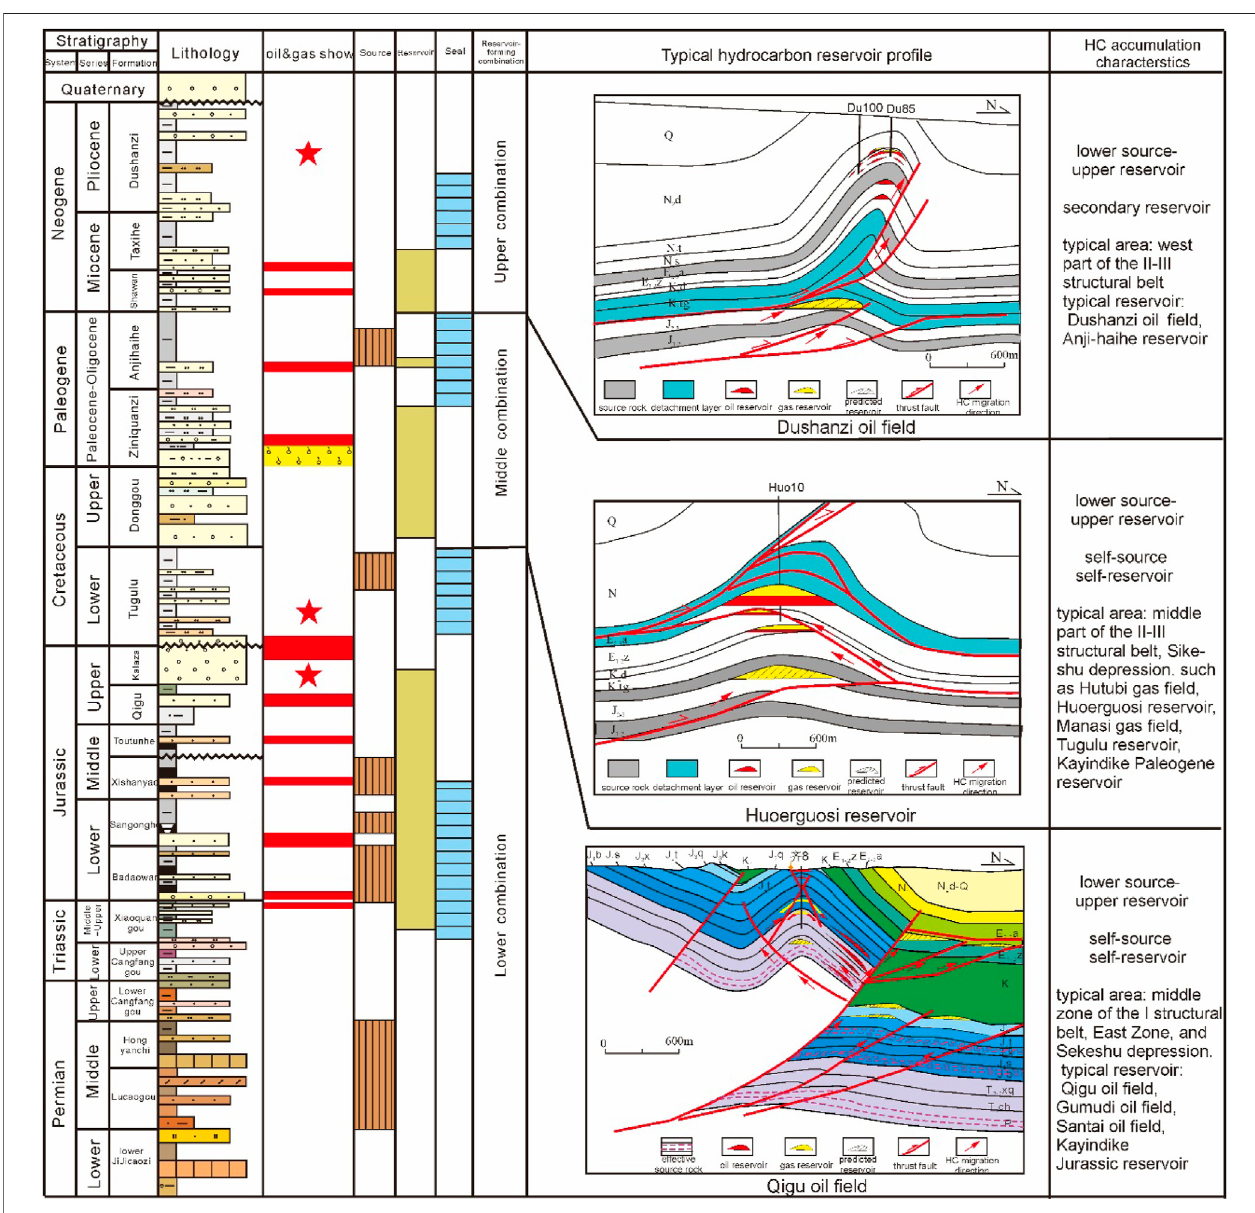
FIGURE 2 | Stratigraphy, hydrocarbon accumulations, and typical cross-sections of oil fi elds in the South Junggar foreland basin.